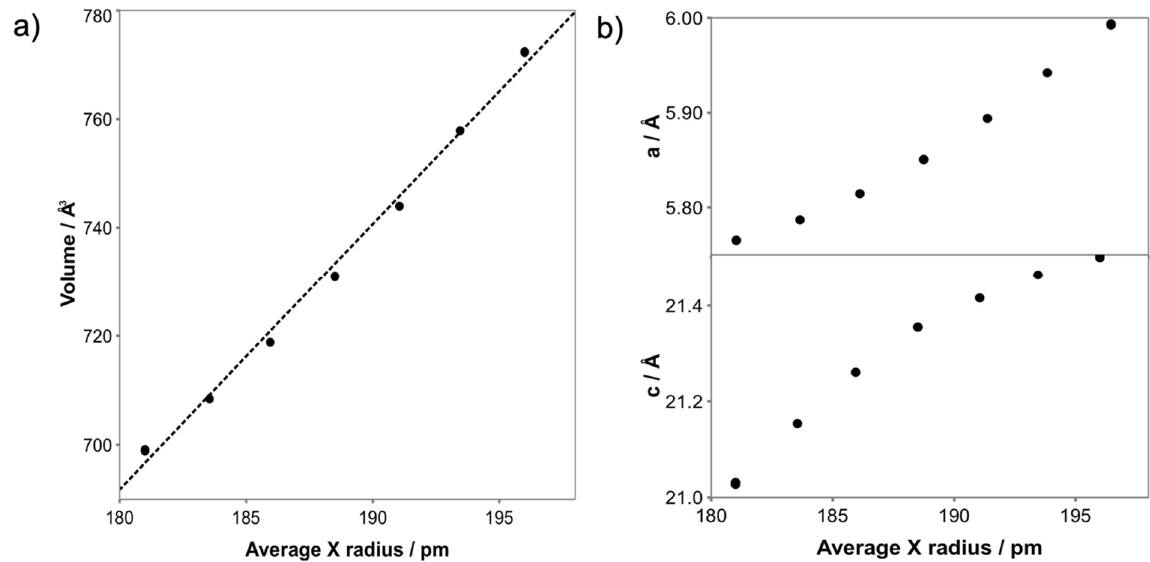
Figure 3. ( a ) Cell volume, ( b ) lattice parameters as a function of average halide anion radius for n = 1 R–P phases Az 2 PbCl x Br 4 − x (0 ≤ x ≤ 4) as determined from Rietveld refinement of PXRD data.